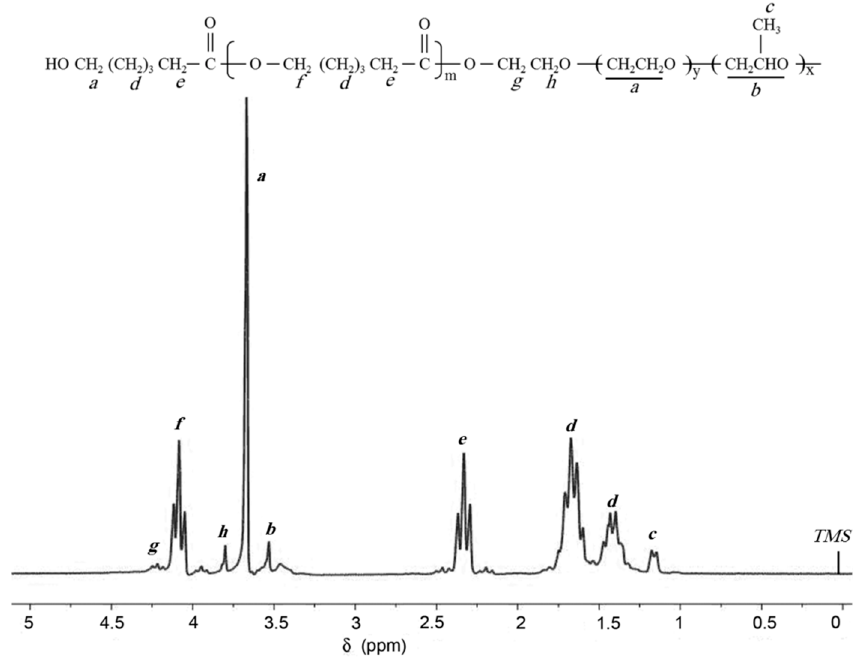
Figure 3. 1 H-NMR spectrum of CUC4 pentablock copolymer.